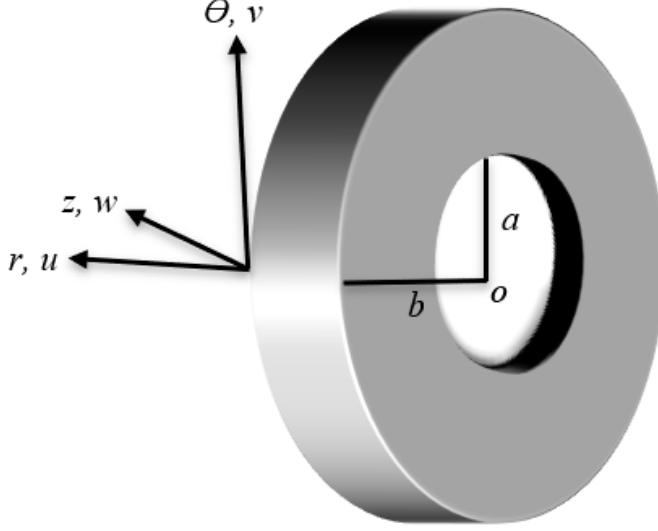
Figure 1. Geometry of annular circular plate.